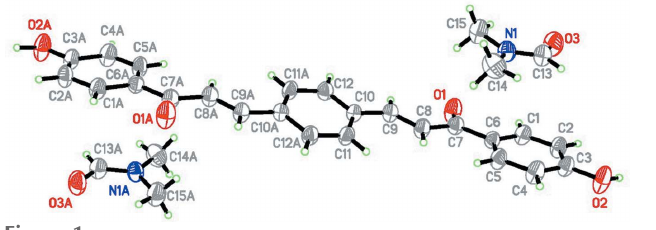
Figure 1 The molecular structure of the title compound, showing the atom- labelling scheme, with 40% probability displacement ellipsoids. Atoms labelled with the suffix A are generated by the symmetry operation 1 (cid:4) x , 2 (cid:4) y , (cid:4) z